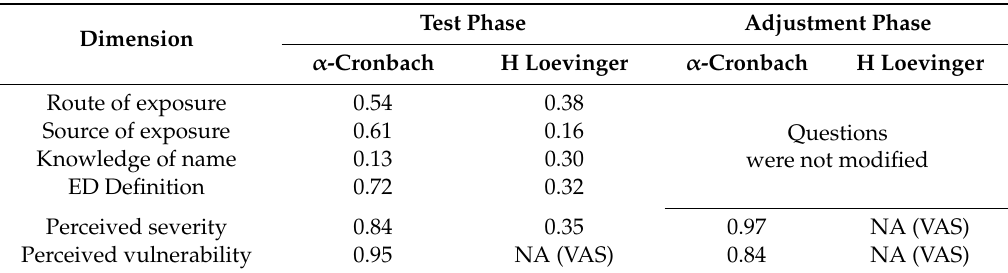
Table 4. Metric proprieties of dimensions in the extract of the PREVED ©